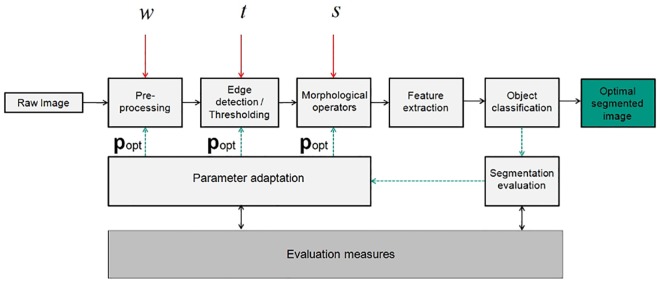
Exemplary feedforward pipeline vs. modified pipeline for the parameter adaptation of segmentation methods for benchmark images.An input grayscale image is first pre-processed to remove noise and shading (parameter w is used to affect the pre-processing outcome). The pre-processed image is then used for image segmentation using either edge detection or intensity thresholding (thresholding parameter t is used in this step). The segmented image is post-processed using morphological operators to remove too big/too small objects (parameter s defines a structuring element for image opening). Features are then extracted from the remaining objects and fed into a classification routine. This pipeline could be modified using structural changes/ parameter adaptation, where evaluation measures are used for segmentation evaluation in order to calculate optimal parameter set popt. Using popt, an optimal image segmentation is obtained.